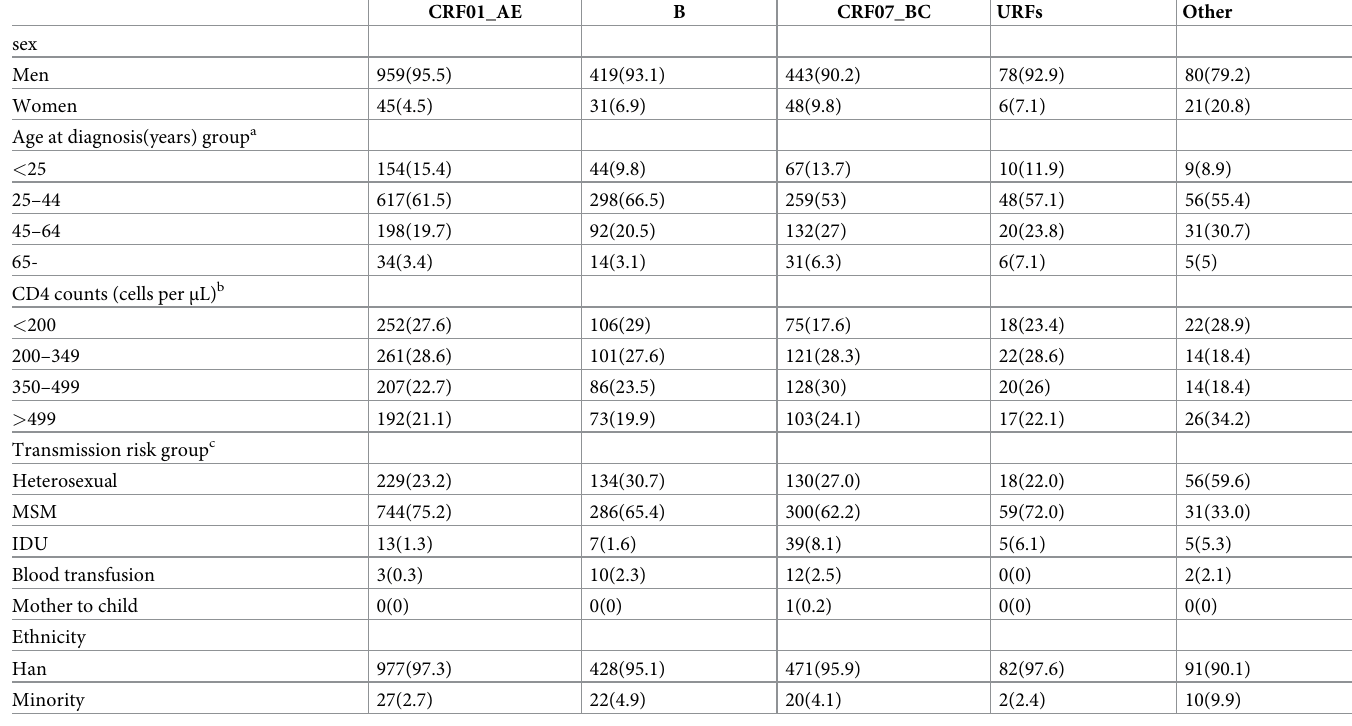
Table 2. Subtype assignment by selected